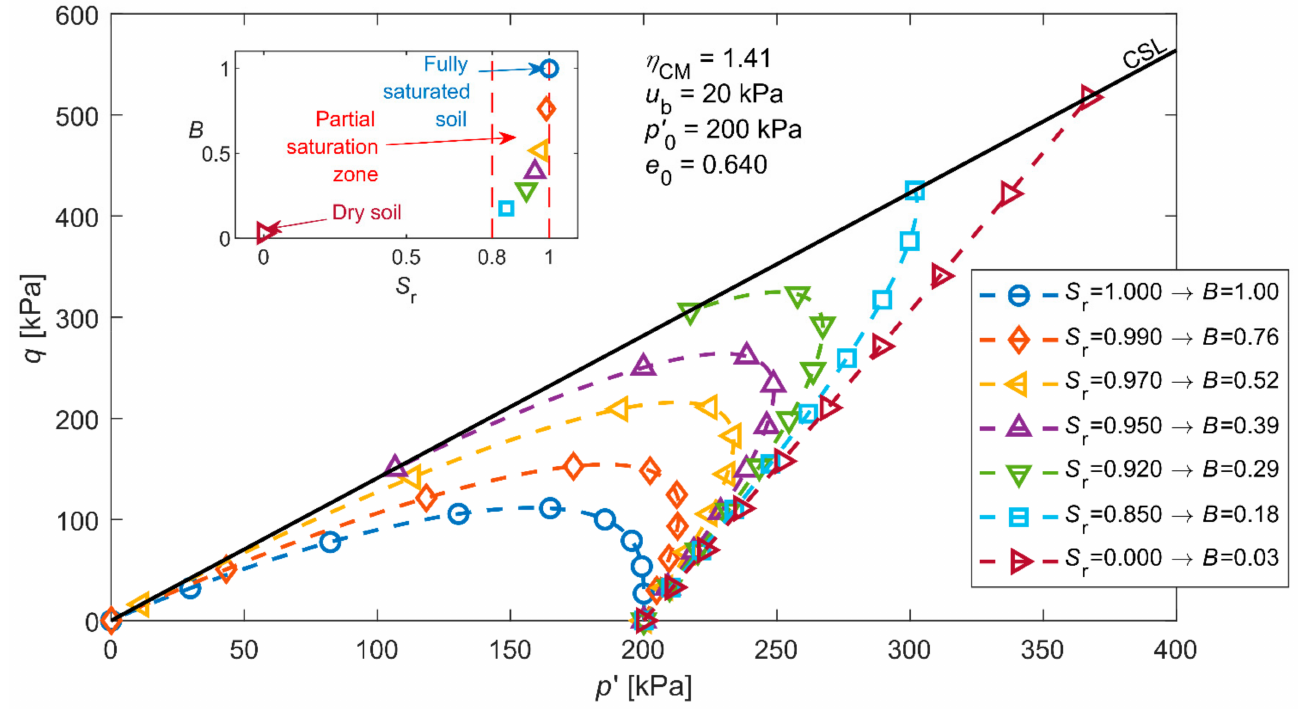
Figure 19. Theoretical prediction of stress paths for different saturations levels for Skarpa